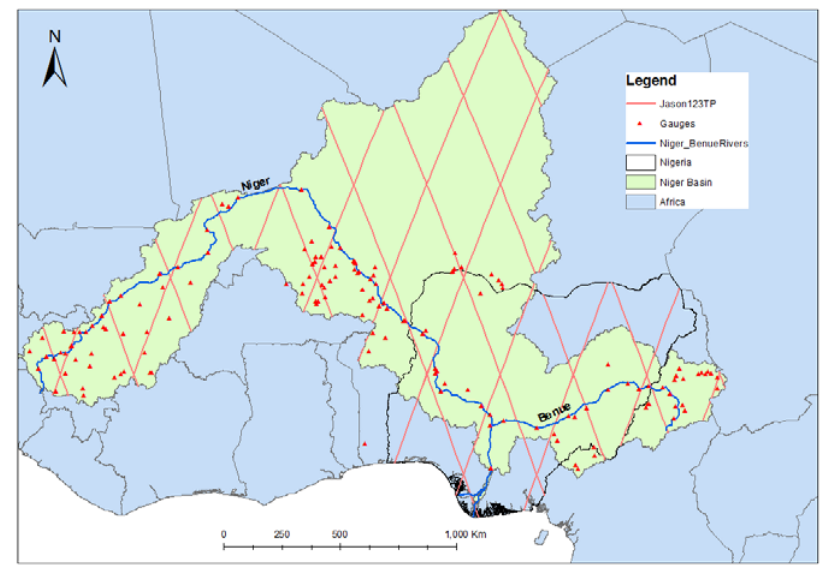
Figure 12. Jason ‐ 1/2/3/TP Altimetry Tracks within the Niger River Basin of West Africa. Figure 12. Jason-1/2/3/TP Altimetry Tracks within the Niger River Basin of West